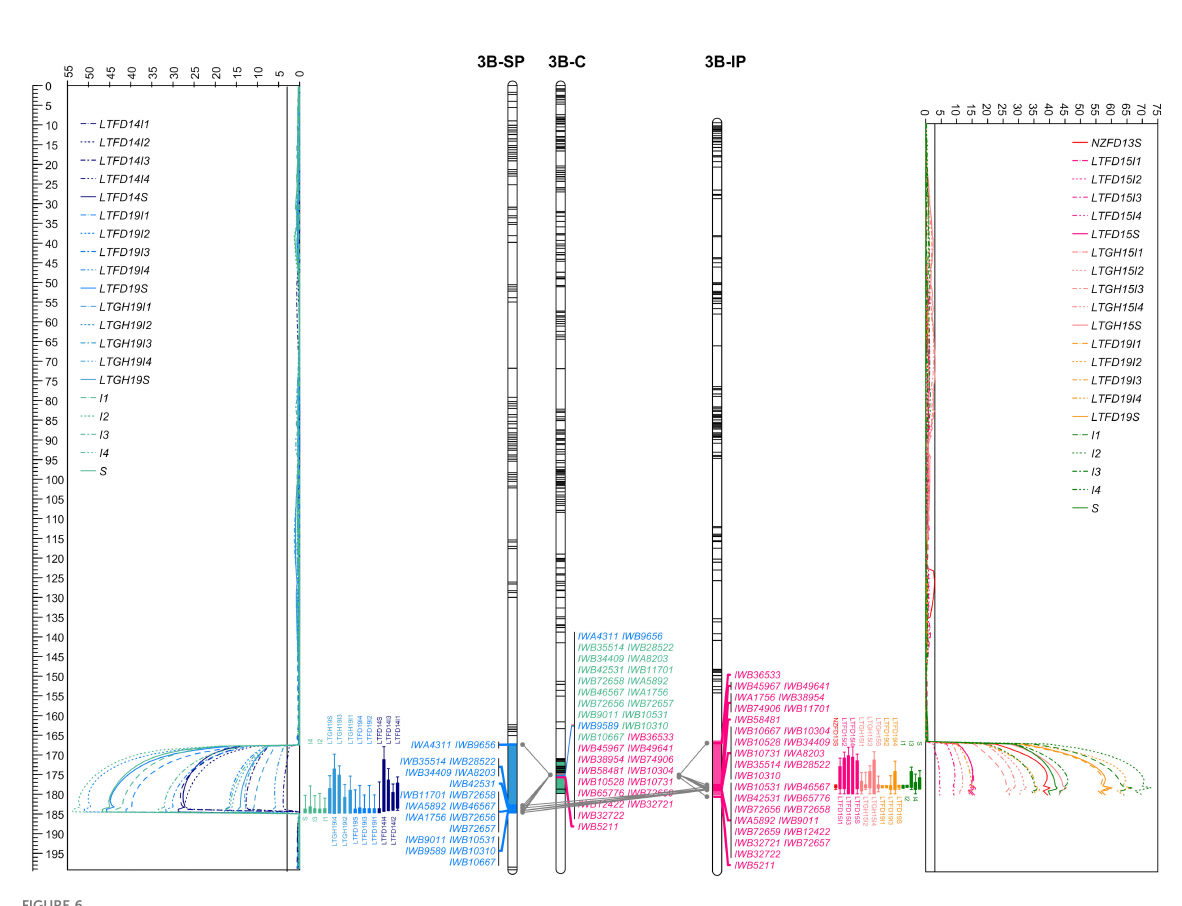
FIGURE 6 The linkage maps of chromosome 3B deciphering the logarithm of odds (LOD) curve plots for major solidness (stem, S and internode, I) quantitative trait locus (QTL) QSst.lrdc-3B detected using composite interval mapping from ‘ Sadash/P2711 ’ (3B-SP) and ‘ AAC Innova/P2711 ’ (3B-IP) doubled haploid populations in each of the trial environments and pooled data along with a chromosome 3B consensus map (3B-C) in middle. Positions of markers are shown as lines on linkage group bars and a scale in cM on the left of the graph. SNP markers common between the two linkage groups and the consensus map are shown by SNP IDs in green font, while markers common between a population map and the consensus map are shown in blue (for ‘ Sadash/P2711 ’ markers) or dark pink (for ‘ AAC Innova/P2711 ’ markers) color. Relationships among linkage groups and consensus map are shown using gray color connections for each common marker. QTL intervals are shown using a different colored segment of linkage group bars, while QTL con fi dence intervals for each environment/trait combination are shown using different colored bars against LOD curve plots. LTFD14(I1-I4, and S), LTFD19(I1-I4, and S), LTGH19(I1-I4, and S), and single letter (and numerals) I1 to I4 and S represent QTL detected in fi eld experiments in 2014, 2019, greenhouse experiment in 2019 and pooled data obtained from Lethbridge, Alberta location for whole stem and culm internodes I1 (uppermost) to I4 (lowermost) ratings of doubled haploid lines of ‘ Sadash/P2711 ’ population. Similarly, NZFD13S, LTFD15(I1-I4, and S), LTGH15(I1-I4, and S), LTFD19(I1-I4, and S), and single letters (and numerals) I1 to I4 and S represent QTL detected in fi eld experiments in New Zealand in 2013, Lethbridge fi eld trials in 2015, Lethbridge greenhouse experiments in 2015, Lethbridge fi eld trial in 2019 and pooled data obtained from Lethbridge, Alberta location for the whole stem and culm internodes I1 (uppermost) to I4 (lowermost) ratings of doubled haploid lines of ‘ AAC Innova/P2711 ’ population. Straight lines across the LOD plot represent the LOD signi fi cance